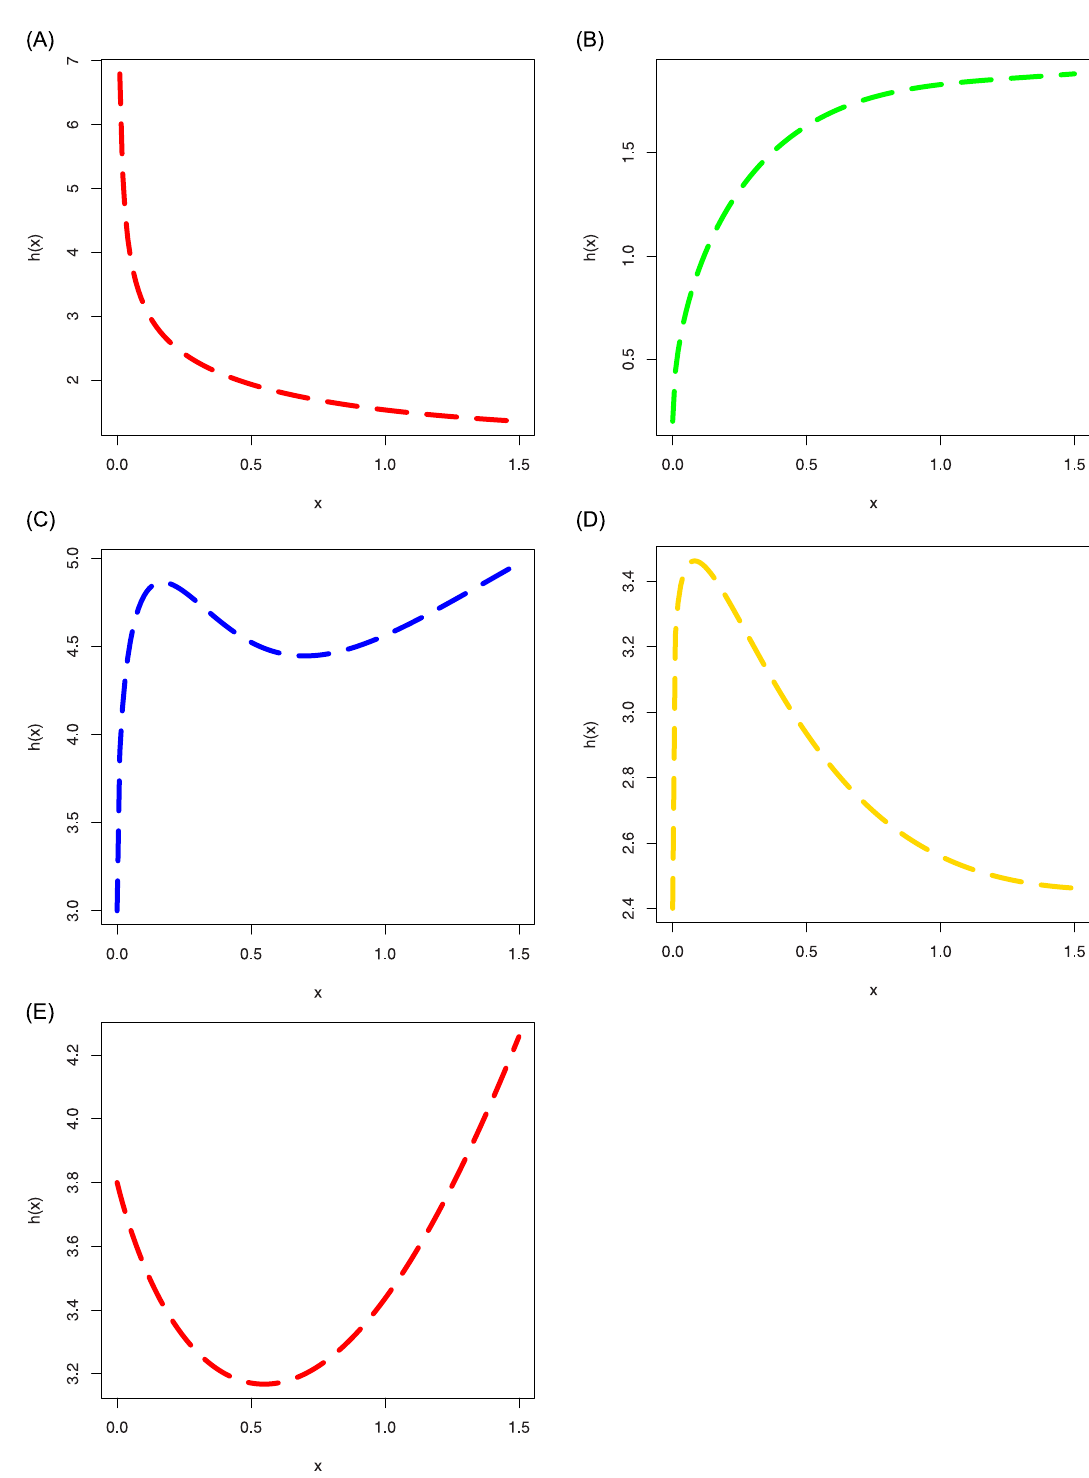
Fig 3. Different hrf plots of the ASM-Weibull distribution.